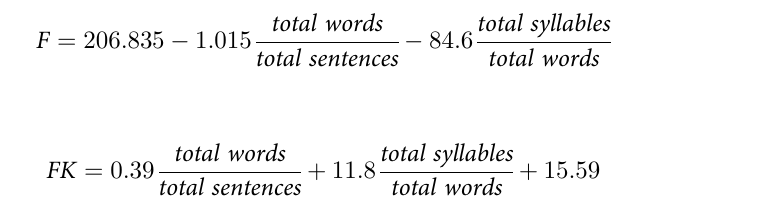
To compute vocabulary richness, we calculate the type-token-ratio and the moving-aver- age-type-token-ratio [55] with window sizes of 10, 20, 30, 40, and 50. We also calculate the Brunet index (Eq 6) and the Honore´ statistic (Eq 7) [56]; i.e., BI ¼ N ð U (cid:0) 0 : 165 Þ ; ð 6 Þ where N is total number of word tokens and U is the total number of unique word types, and 100 log N ; ð 7 Þ HS ¼ 1 (cid:0) N 1 U where N is the total number of word tokens, U is the total number of unique word types, and N 1 is the number of hapax legomena (i.e., words used only once). The readability of transcripts is calculated by the Flesch reading score (Eq 8), and the Flesch-Kincaid grade level (Eq 9) [57]; i.e.,